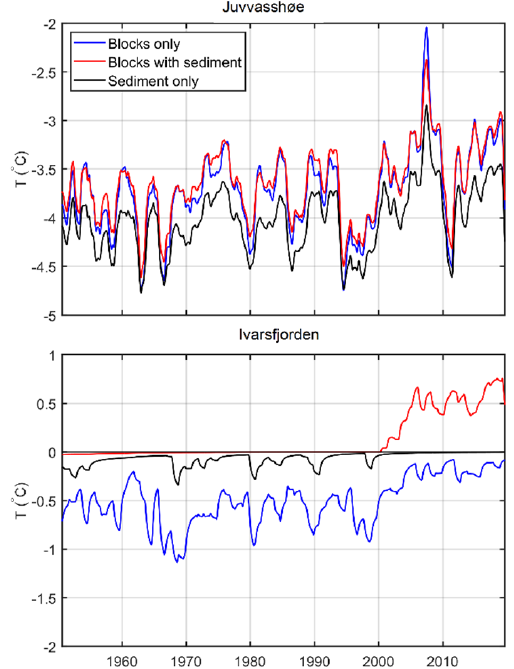
Figure 9. Ground temperature at 5m depth for the idealized strati- graphies under drained conditions; sf = 1 . 0 for Ivarsfjorden and sf = 0 . 25 for